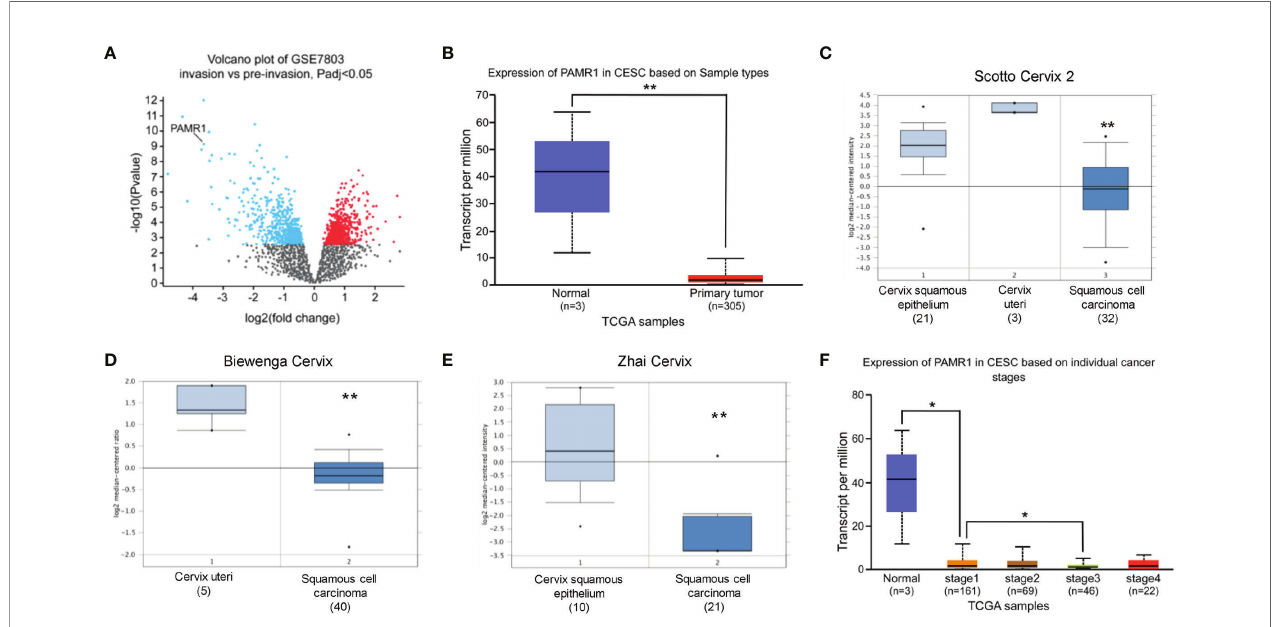
FIGURE 1 | The expression of PAMR1 in cervical cancer. (A) Volcano plot of the distribution of differentially expressed genes (DEGs) in GSE7803: blue dots represent downregulated DEGs, whereas red dots are upregulated DEGs in invasive cervical squamous cell carcinomas. PAMR1 gene was indicated. (B) The expression of PAMR1 in TCGA-CESC from the UALCAN database. (C – E) The expression of PAMR1 between CECC and normal cervix uteri tissue in three GEO datasets from the Oncomine ™ database. (F) The expression of PAMR1 in TCGA-CESC based on individual cancer stage in the UALCAN database. * p < 0.05, ** p <